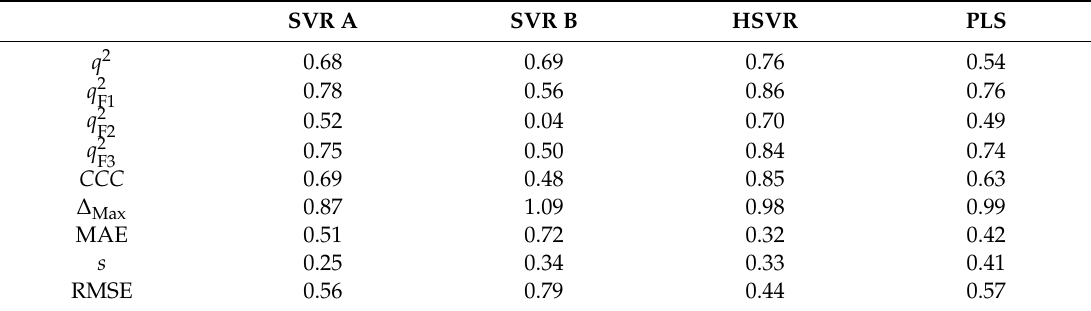
, q 2 , and q 2 , concordance F1 F2 F3